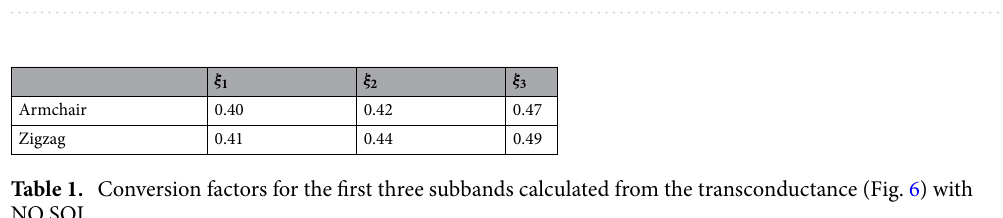
Figure 6. The transconductance d 2 I / dV SD dV g SOI ( a , b ) and NO SOI ( c , d ). Dashed lines denote the conductance levels (marked by numbers) and are used to calculate gate-voltage to energy conversion factors.